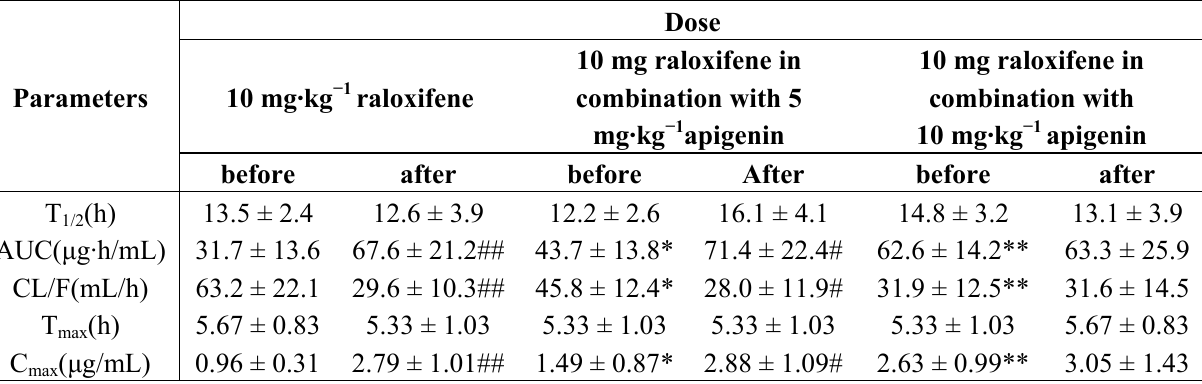
*compared with the raloxifene (10 mg·kg − 1 ) alone group before hydrolysis (*p ＜ 0.05; **p ＜ 0.01); # compared with the pharmacokinetic parameters of raloxifene before hydrolysis